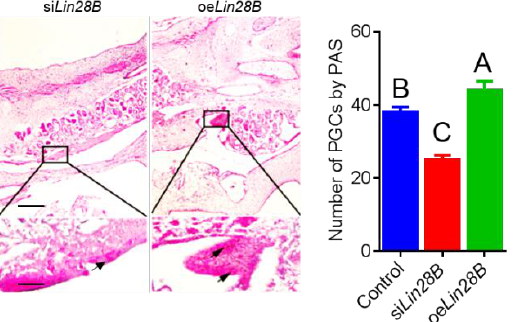
Figure 4. Quantity detection of PGCs by Periodic Acid-Schiff(PAS) staining; up-scale bar: 200 μm; down-scale bar: 40 μm. Left: the PGCs were marked by arrow, Right: statistical analysis of the number of PGCs in genital ridge after overexpression or interference of Lin28B . Different uppercase letters represent highly significant, and the same letters represent no